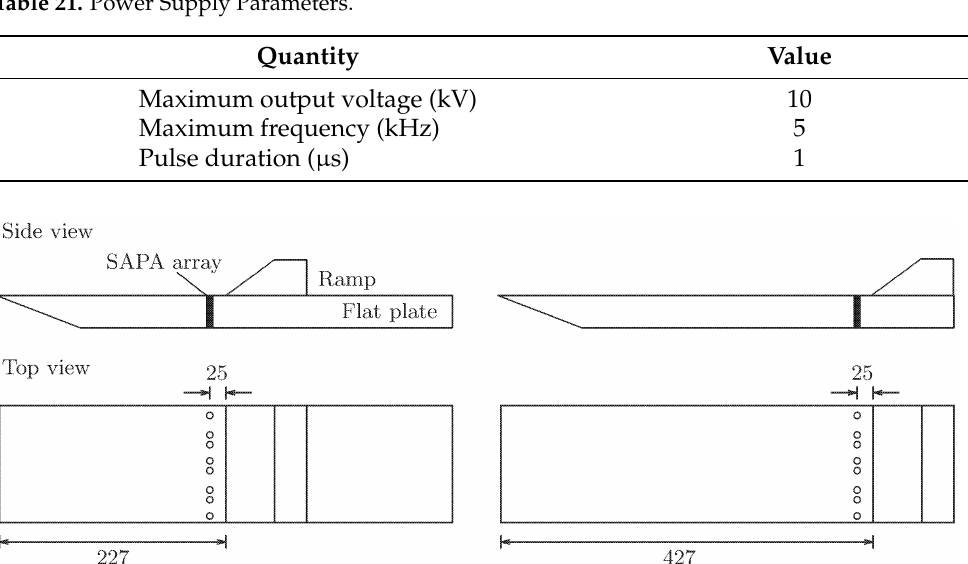
Table 21. Power Supply Parameters.